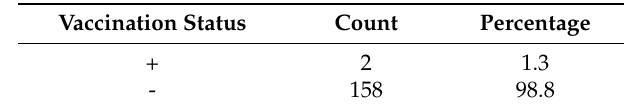
Table 3. HBV vaccination status of the study group ( n =